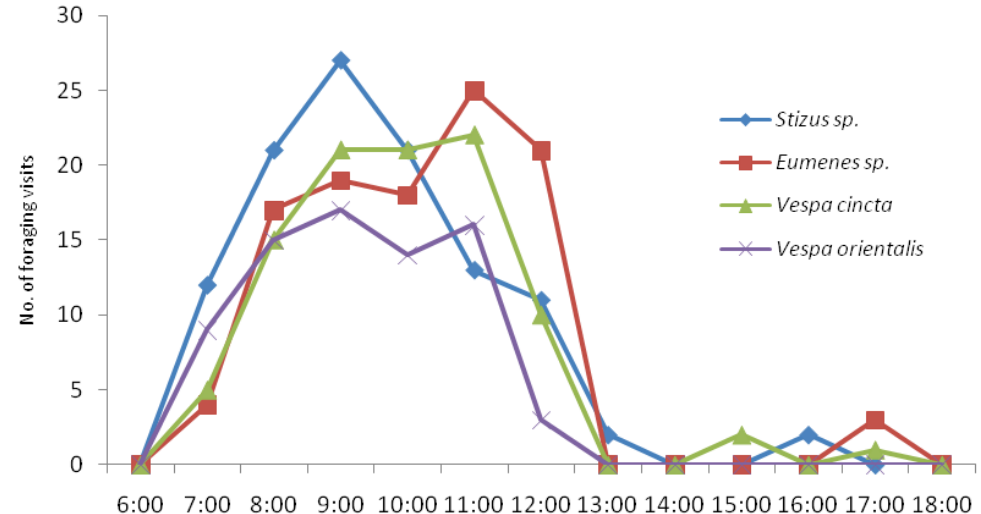
Figure 2. Hourly foraging activity of wasps on Syzygium